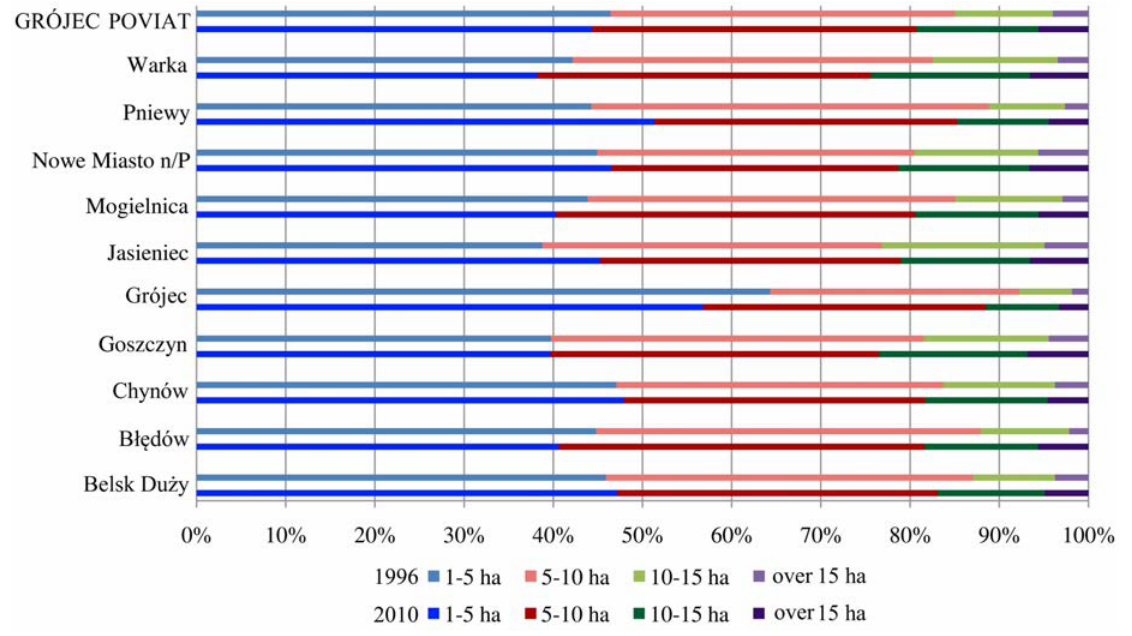
Fig. 8. Size structure of individual farms in the communes of Grójec poviat in 1996 and 2010. Source: own compilation based on Agricultural Census 1996 and Agricultural Census